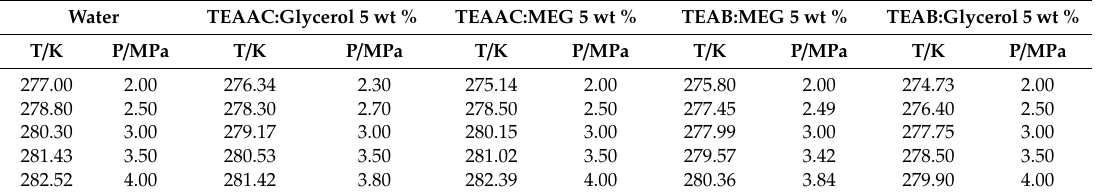
Table 3. Hydrate Liquid-Vapor Equilibrium (HLVE) data with and without five wt % inhibitors (Deep Eutectic Solvent (DES) of 1:7 molar ratios) for CO 2 gas.